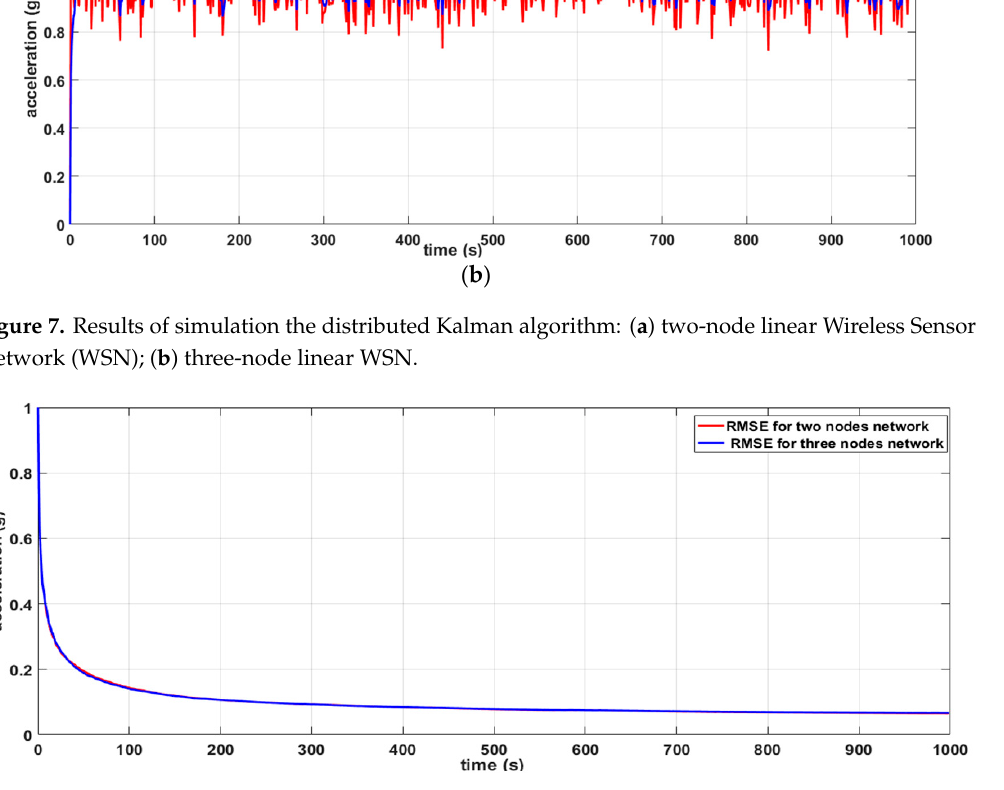
Figure 8. Comparison of root mean square error (RMSE) for node S1 in the case of two-node and three-node linear WSN.